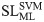
The estimation of the three parameters of the Ricker model of 100 data sets with Tobs = 105.The SLMLSVM estimation clearly outperforms the SLMLGrid estimation.